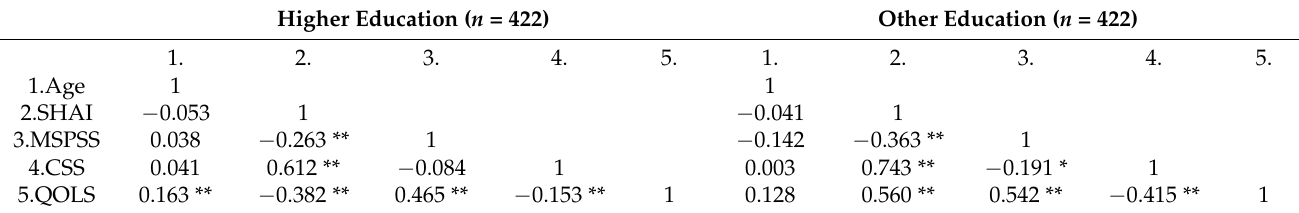
Table 3. Bivariate correlations regarding education.